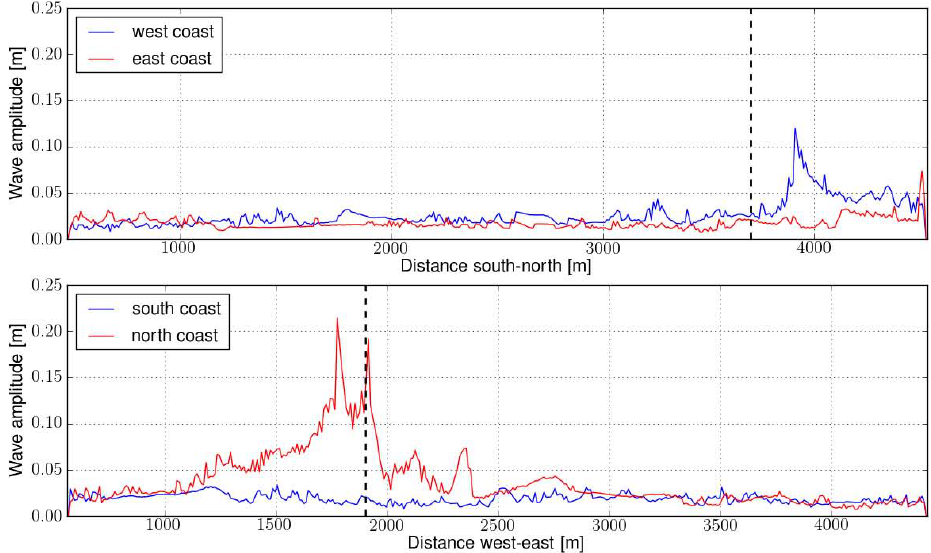
Fig. 5. Maximum wave amplitude at the 5m isobath along the coast of Karymskoye lake. The location of the center of the source (crater) is indicated by a black, dashed